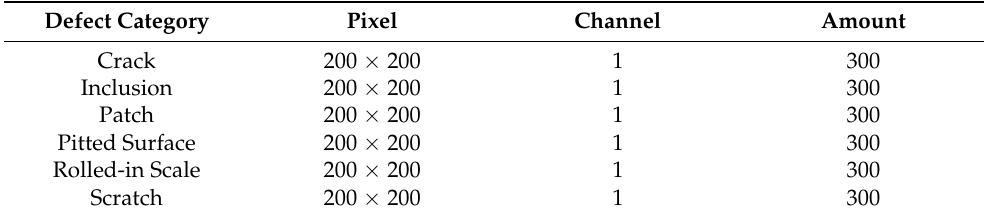
Figure 7. Example of defective image and corresponding label. ( a ) Crack, ( b ) Inclusion, ( c ) Patch, ( d ) Pitted Surface, ( e ) Rolled-in Scale, ( f ) Scratch. Table 2. Information on the data set.